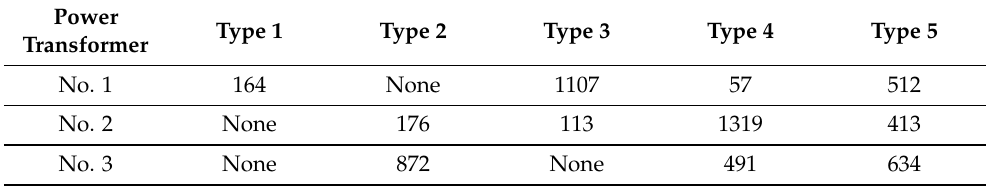
Table 1. Fault distribution of the target